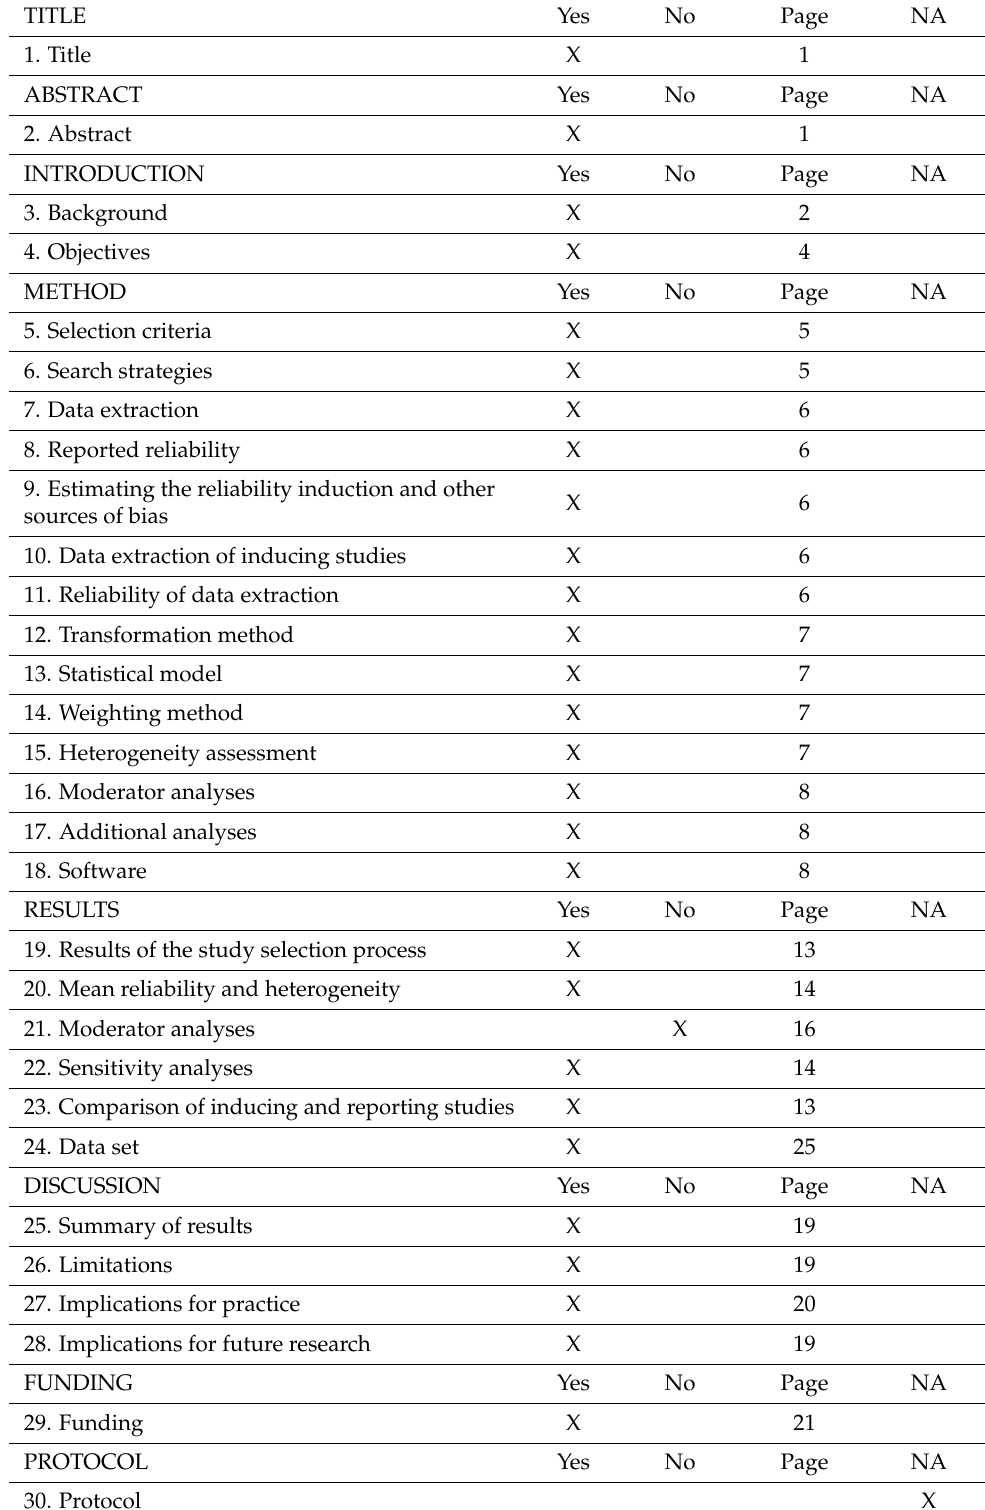
Table A4. Checklist for the corroboration of the meta-analytical report according to the REGEMA